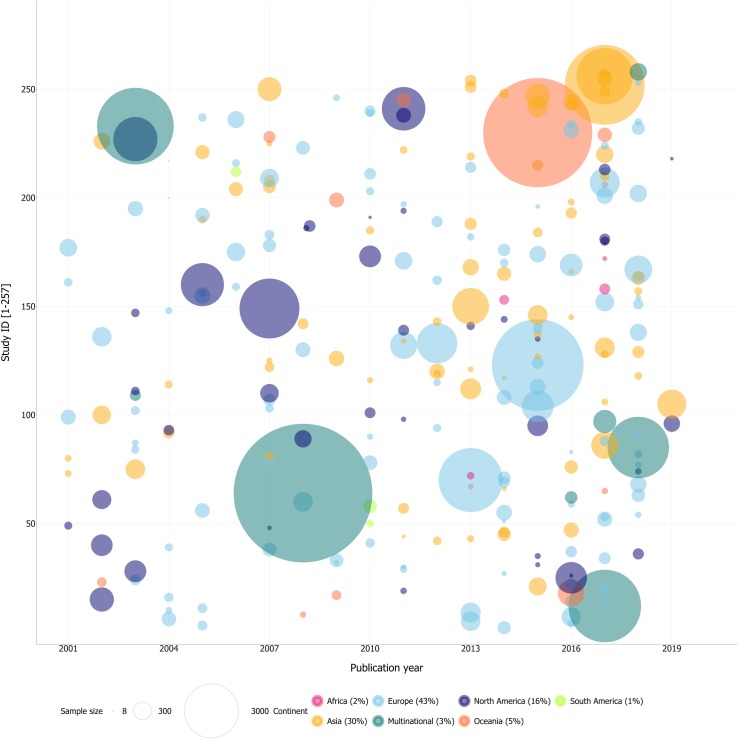
Sample size and origin of included studies (N = 257).